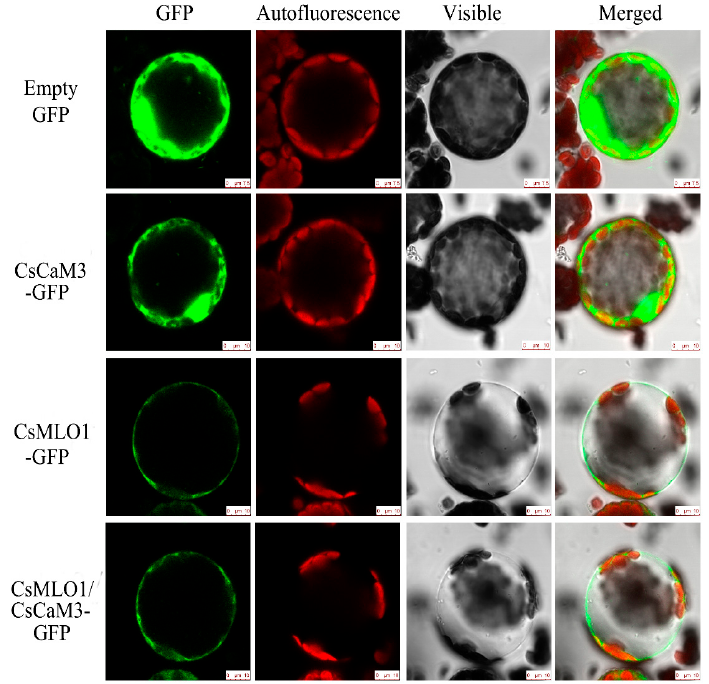
Figure 6. Subcellular localization analyses of CsCaM3 -GFP, CsMLO1 -GFP, and CsCaM3 -GFP+ CsMLO1 -GFP in transiently transformed N. benthamiana protoplasts. Confocal images of green fluorescent protein (GFP), CsCaM3 -GFP, CsMLO1 -GFP, and CsCaM3 -GFP+ CsMLO1 -GFP in N. benthamiana protoplasts 3 days after Agroinfiltration . Chloroplast autofluorescence (red). Bars = 50 μ m.